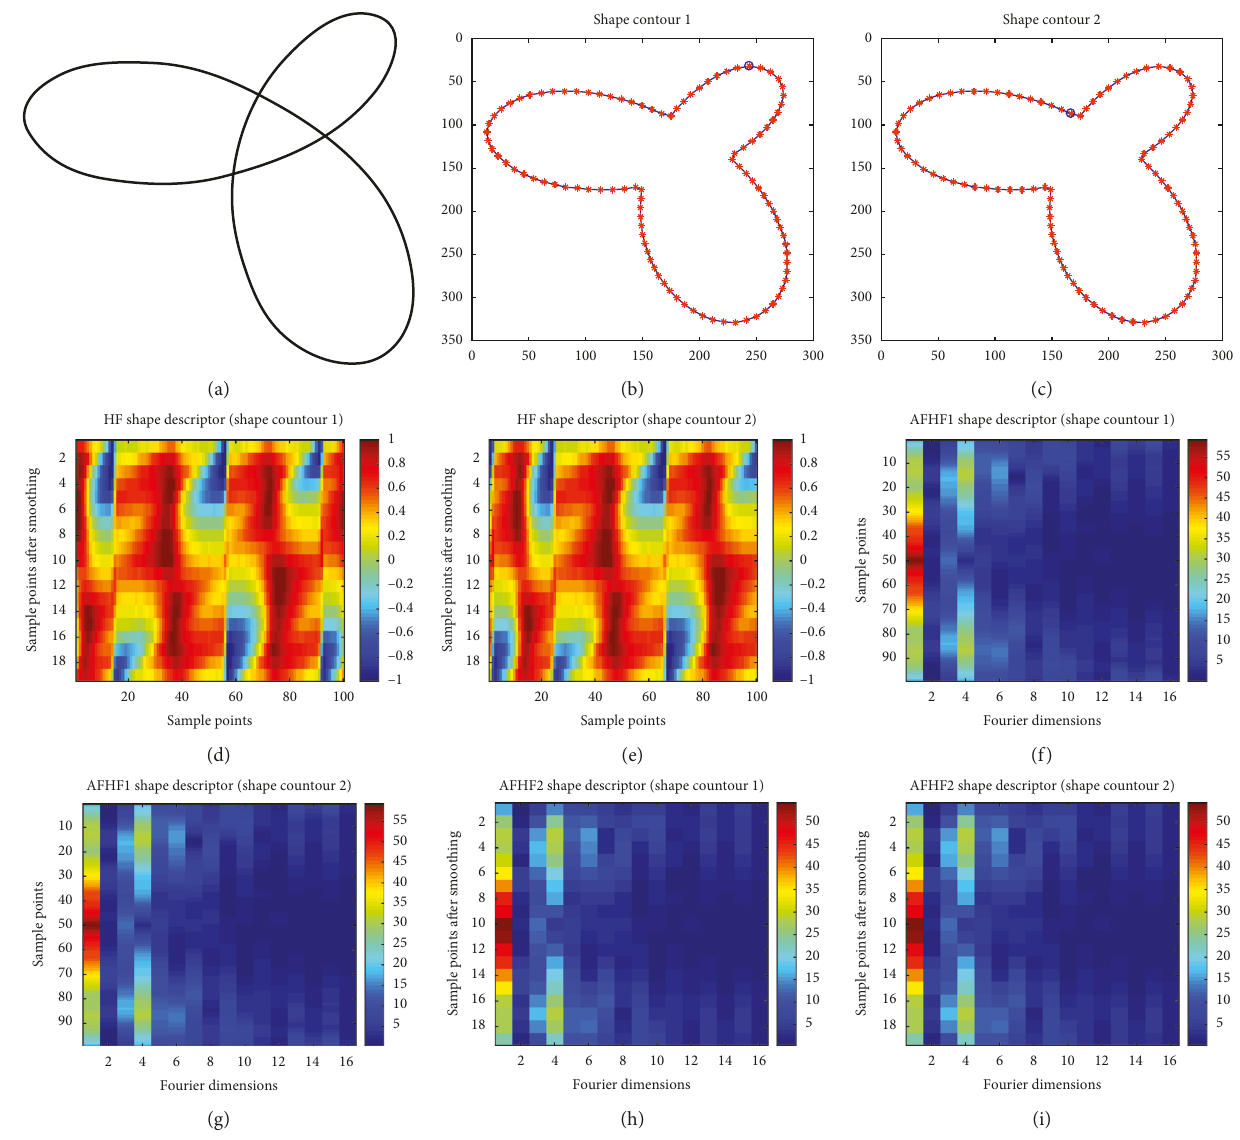
Figure 3: Comparison of HF, AFHF1, and AFHF2 descriptor from different starting points. (a) Petal-shaped shaft orbit; (b) shape contour 1 of (a); (c) shape contour 2 of (a); (d) HF shape descriptor of (b); (e) HF shape descriptor of (c); (f) AFHF1 shape descriptor of (b); (g)